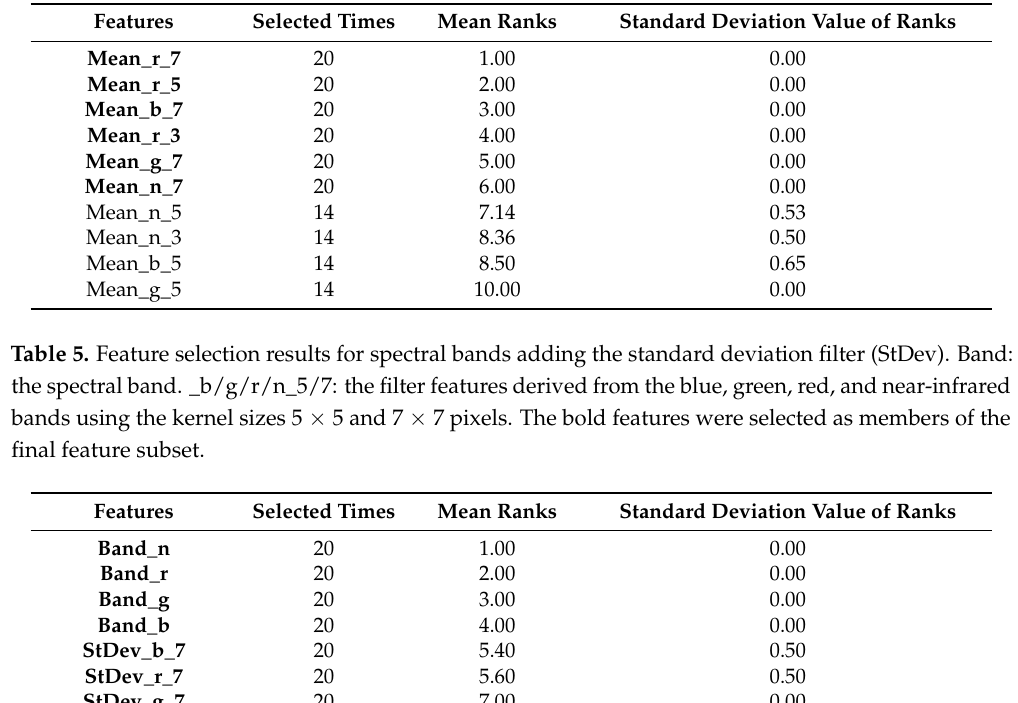
Table 4. Feature selection results for spectral bands adding the mean filters (Mean). _b/g/r/n_3/5/7: the filter features derived from the blue, green, red, and near-infrared bands using the kernel sizes 3 × 3, 5 × 5, and 7 × 7 pixels. The bold features were selected as members of the final feature subset.